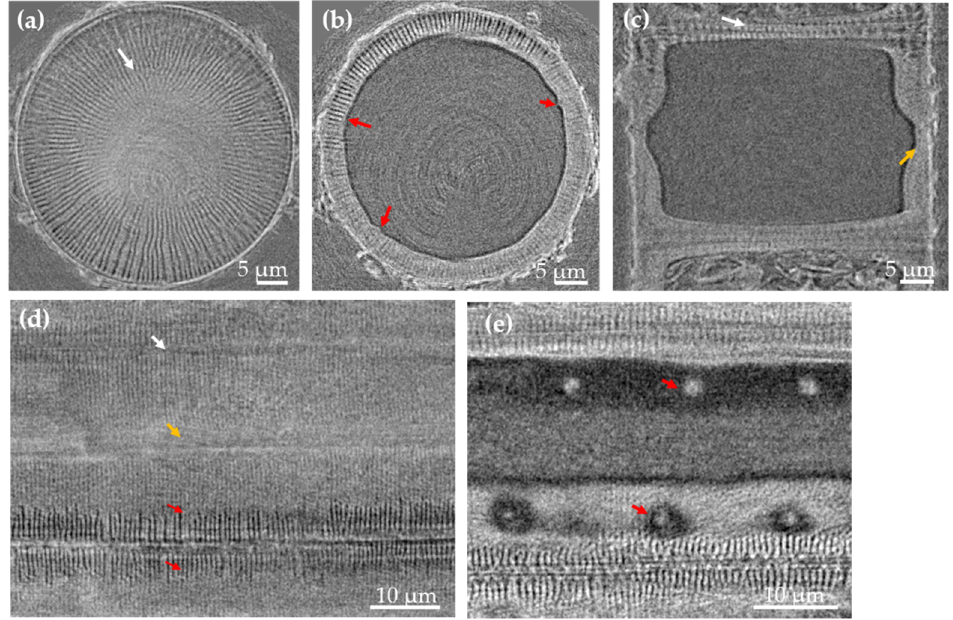
Figure 3. Nano-XCT images of the Melosira frustule. ( a , b ) Valve view of the frustule and ( c ) girdle view of the frustule, unfolded cylindrical wall of the Melosira frustule from the surface ( d ) to the interior ( e ).